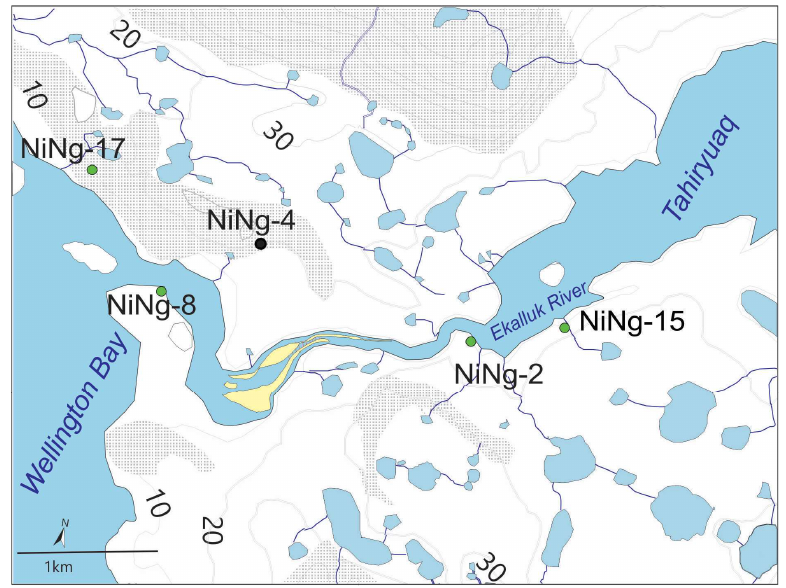
Figure 7. Late Dorset (950–660 cal B.P) site location situated on proposed paleogeography at approximately 1400 cal B.P. Marine limit would have been at the modern 5 m contour. Yellow indicates possible sand bars.